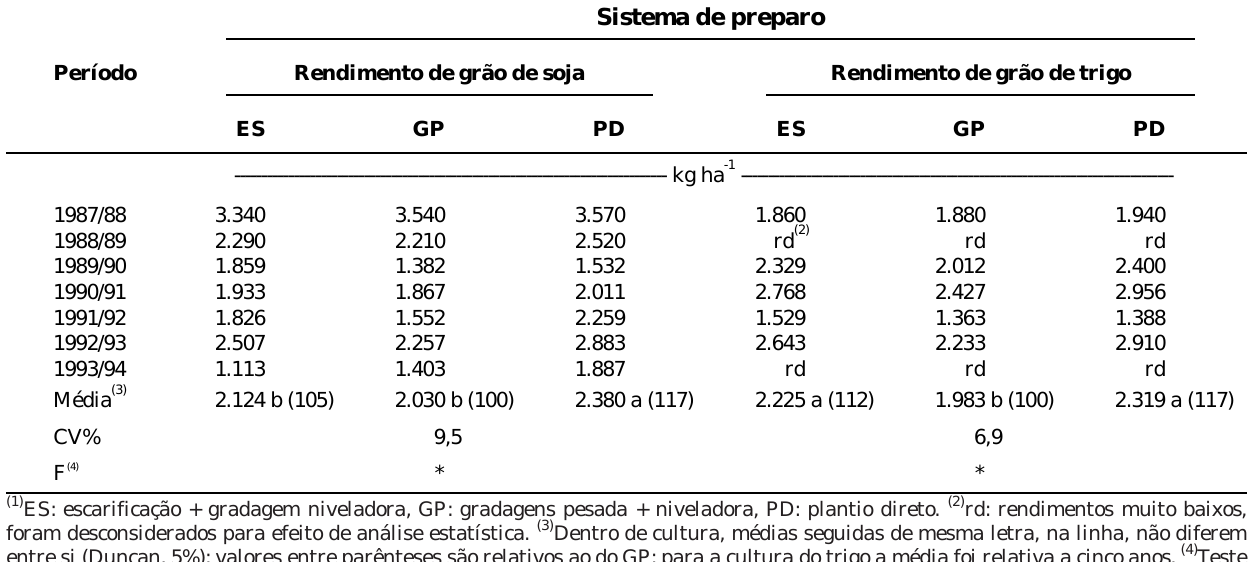
Figura 2. Rendimentos relativos acumulados de grãos de soja (RS) em plantio direto (PD) e com escarificação + gradagem niveladora (ES), considerando os sistemas de preparo com gradagens pesada + niveladora (GP), em função do tempo de cultivo.